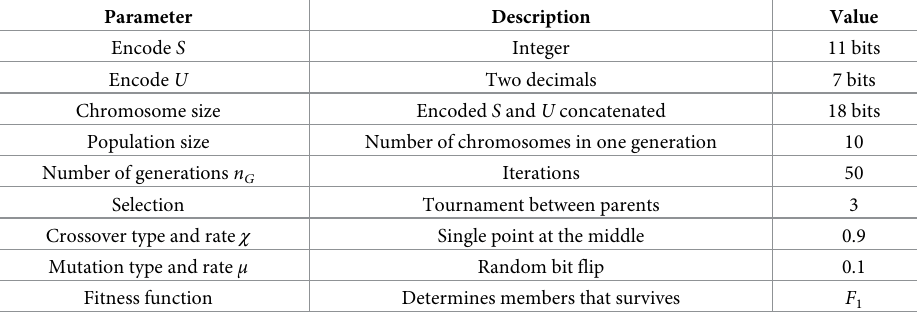
Table 4. GA implementation